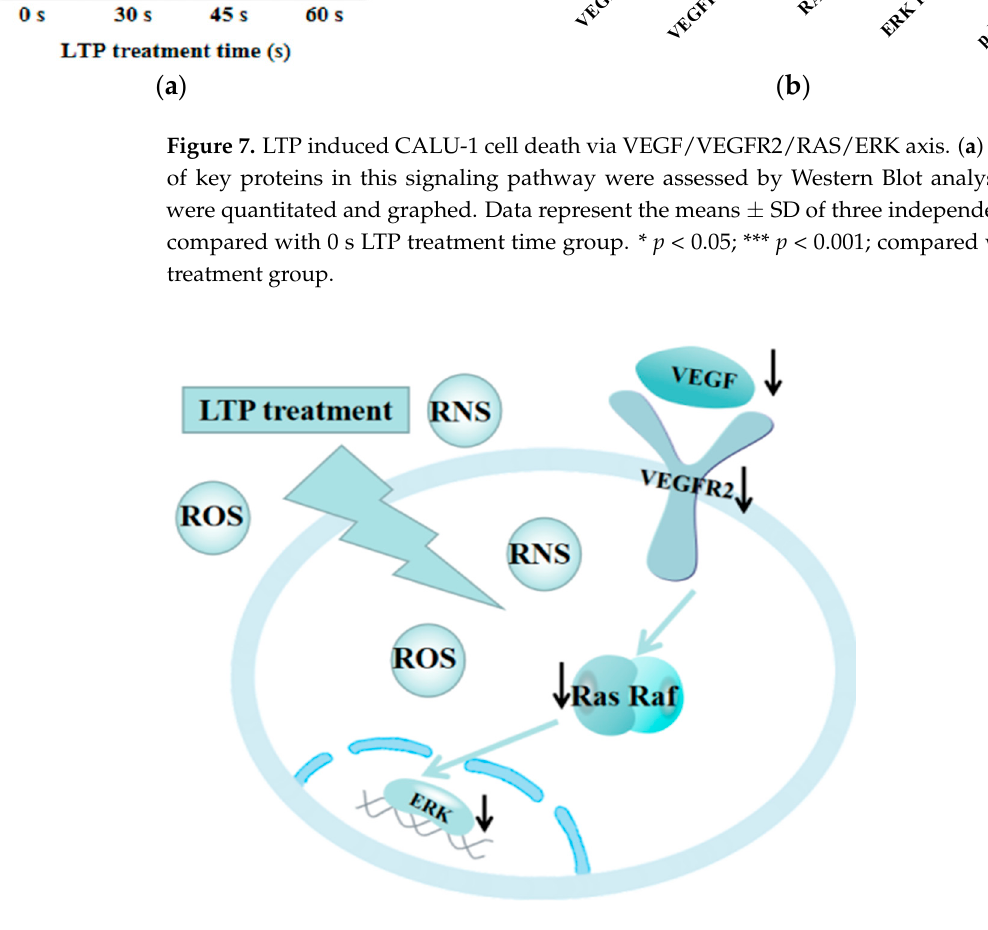
Figure 7. LTP induced CALU-1 cell death via VEGF/VEGFR2/RAS/ERK axis. ( a )The expressions of key proteins in this signaling pathway were assessed by Western Blot analysis, ( b ) the data were quantitated and graphed. Data represent the means ± SD of three independent experiments, com- pared with 0 s LTP treatment time group. * p < 0.05; *** p < 0.001; compared with the 0 s LTP treat- ment group.